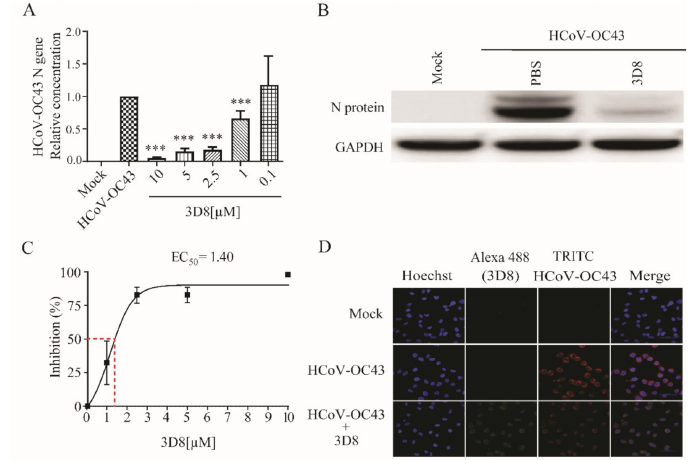
Figure 4. In vitro antiviral effect of 3D8 against human coronavirus OC43 (HCoV-OC43). ( A ) Dose- dependent inhibition of HCoV-OC43 by 3D8. Vero E6 cells were infected with HCoV-OC43 at 2 hpi and treated with a range of 3D8 concentrations for 48 hrs. The cells were harvested, and the virus copy number was determined using qPCR. ( B ) The N protein of HCoV-OC43 was identified by Western blot. ( C ) Percent inhibition of HCoV-OC43 replication was shown by 3D8 in Vero E6 cells. Replication was measured via quantification of the viral RNA level. ( D ) At 48 hpi, the cells were washed with PBS and fixed using methanol. Then, they were permeabilized with buffer and blocked with BSA. The cells were then incubated with primary antibodies overnight. After incubation, TRITC-conjugated anti-mouse and Alexa 488-conjugated anti-rabbit antibodies were added. Hoechst was used to stain the nucleus. Data presented here are representative of at least three independent experiments performed in triplicate. *** p < 0.001; one-way ANOVA test; ns: non-significant.